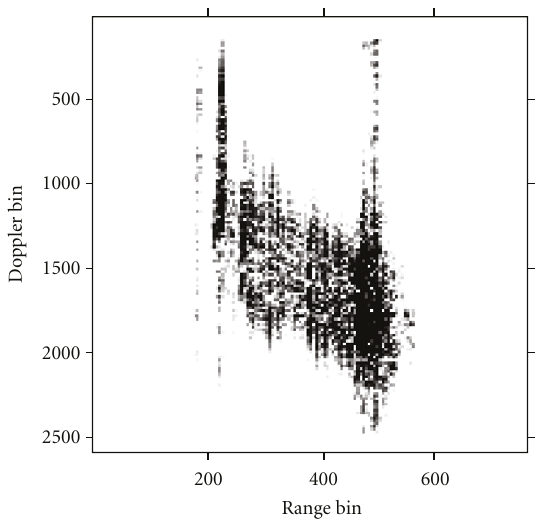
Figure 10: ISAR image of ship target based on the RD algorithm.